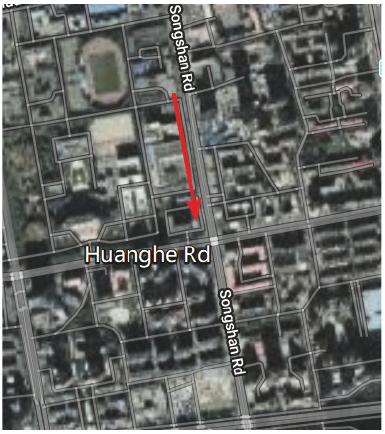
Figure 7: The experiment